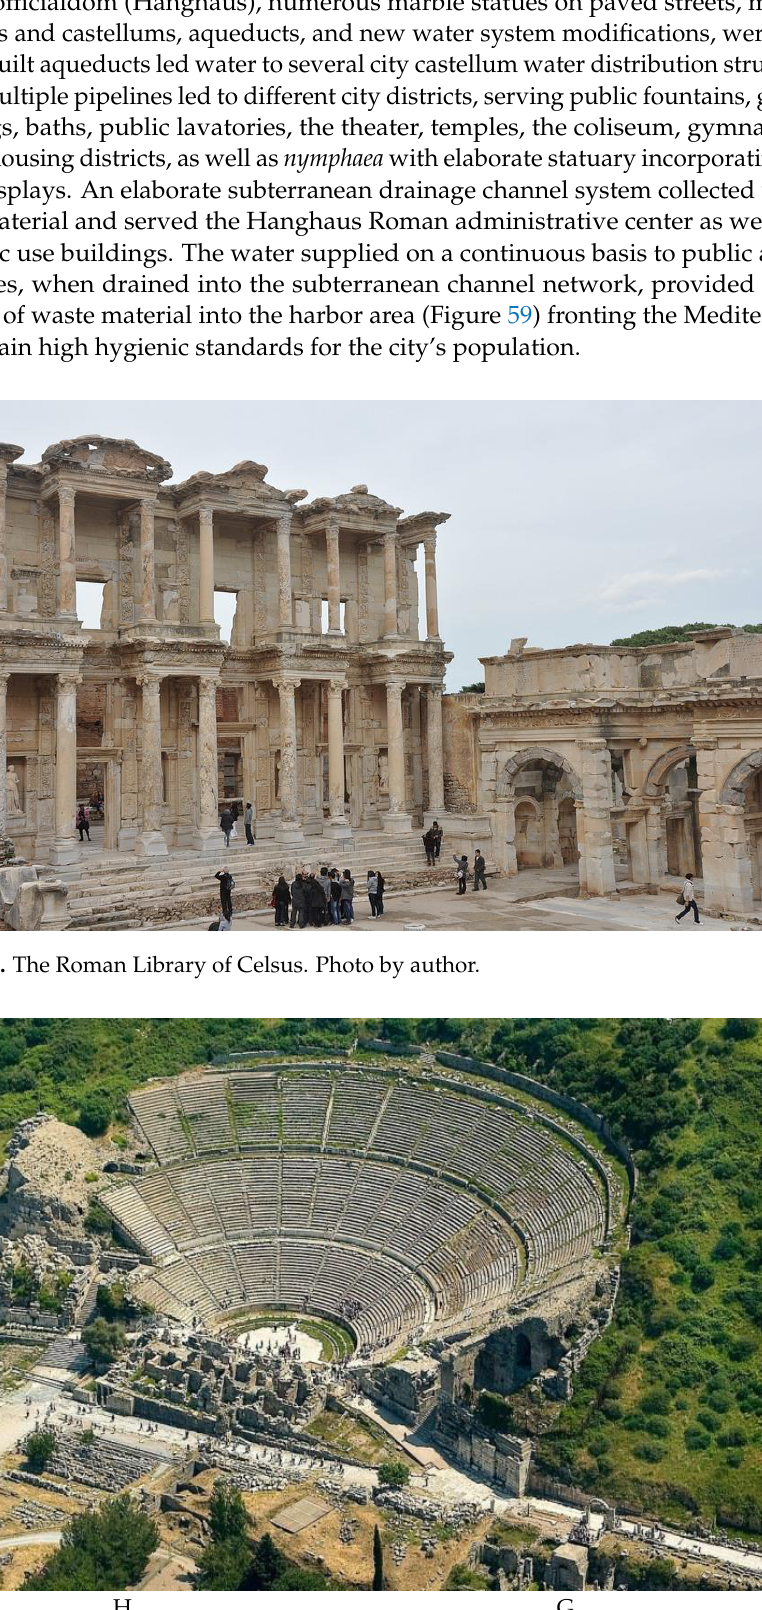
Figure 58. The Roman Theater. Aerial photo by author. H represents an earlier Greek structure adjacent to the Theater; G represents a Greek fountain house still in use in Roman times.